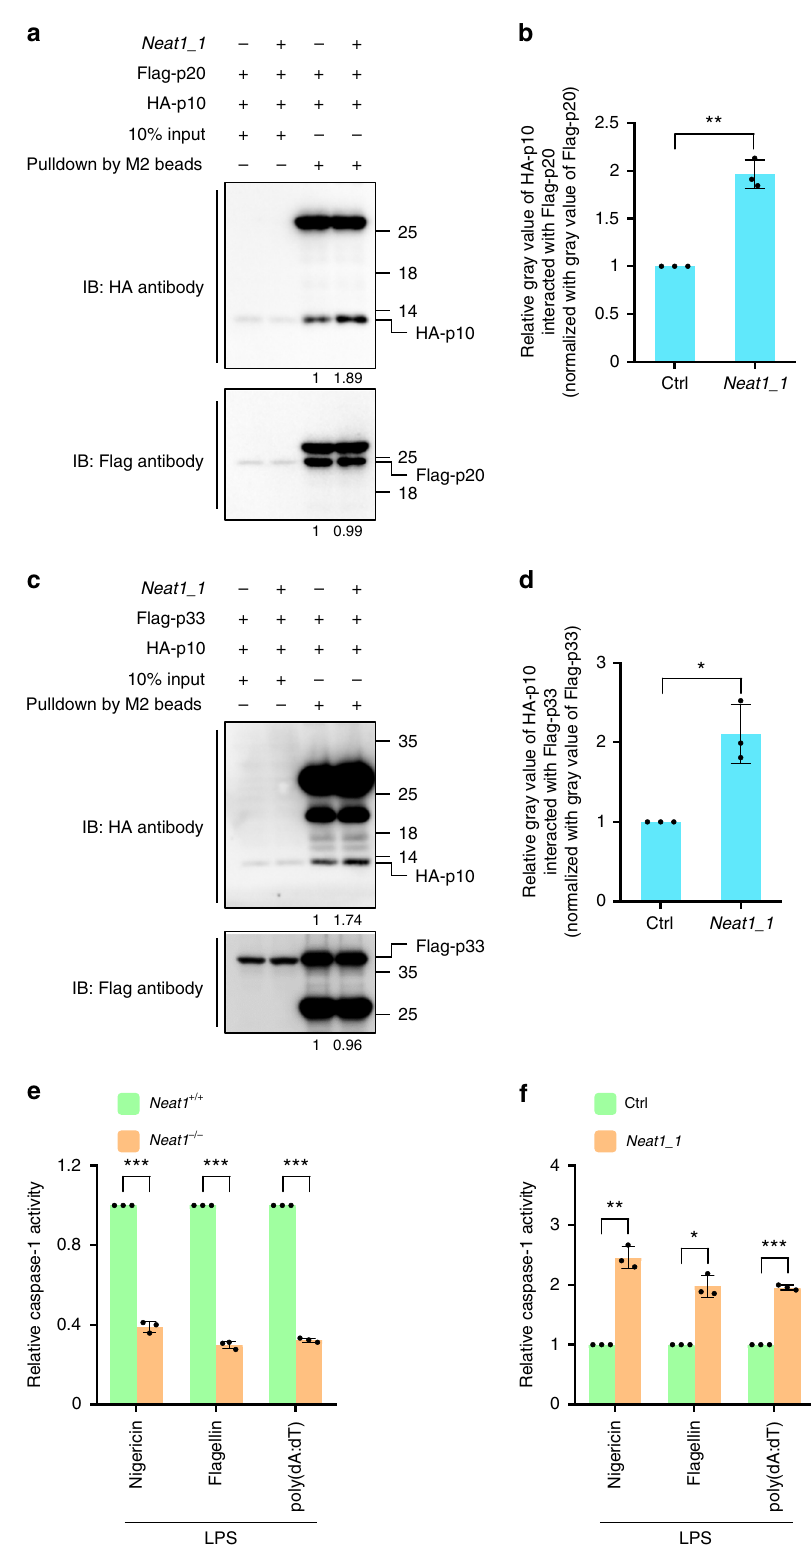
Fig. 5 Neat1 stabilizes the caspase-1 hetero-tetramers and increases caspase-1 activity. a – d 293T cells were infected with lentiviruses expressing control RNA or Neat1_1 and then co-transfected with Flag-p20 and HA-p10 ( a , b ) or Flag-p33 and HA-p10 ( c , d ). Cell lysates were incubated with anti-Flag mAb (M2) beads. Input samples and pull-down products were subjected to western blotting ( a , c ). Relative ratios of HA-p10 pulled down by Flag-p20 ( b ) or Flag-p33 ( d ) were shown in histogram, based on the data of three independent replication experiments. e Neat1 + / + and Neat1 − / − BMDMs were primed with LPS and then activated with nigericin, fl agellin, or poly(dA:dT). Mature caspase-1 activity was measured. f Control or Neat1_1 overexpressing iBMDMs were primed with LPS and then activated with nigericin, fl agellin, or poly(dA:dT). Mature caspase-1 activity were measured. In b , d , e and f , data shown are mean ± SD ( n = 3). * P < 0.05, ** P < 0.01, *** P < 0.001, two-tailed t -test. Source data are provided as a Source Data fi